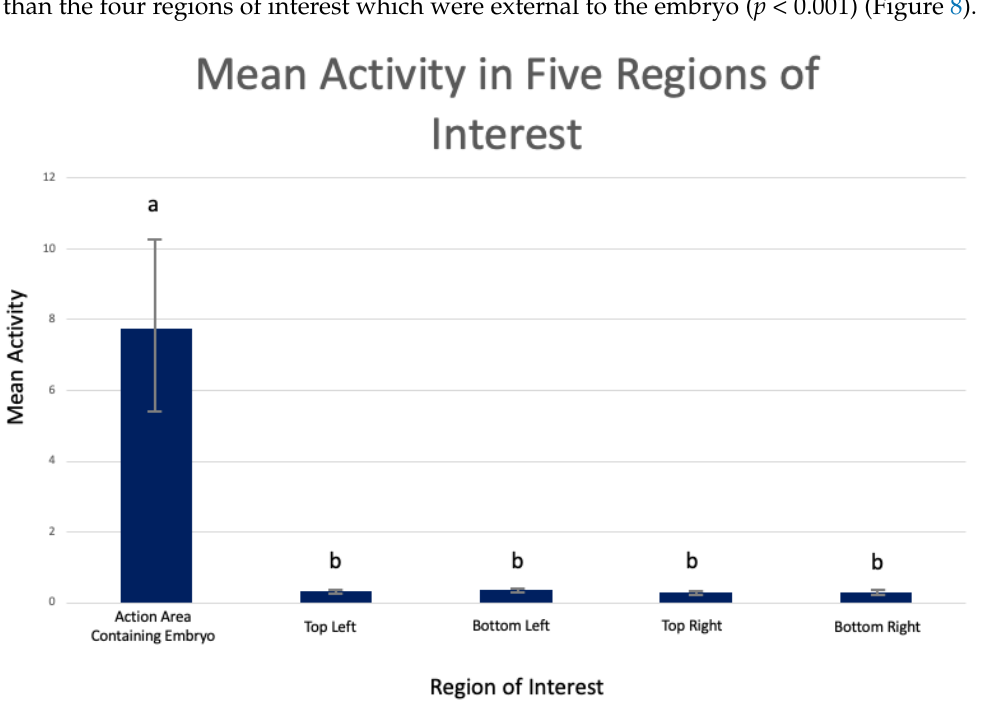
Figure 8. Mean activity in the five regions of interest. Activity in the 400 × 400-pixel bounding box containing the action area of the embryo proper was significantly higher than the activity in the four 400 × 400-pixel bounding boxes which were external to the embryo. Bars with different letters a–b represent statistical differences in mean activity ( p < 0.001). Bars indicate standard